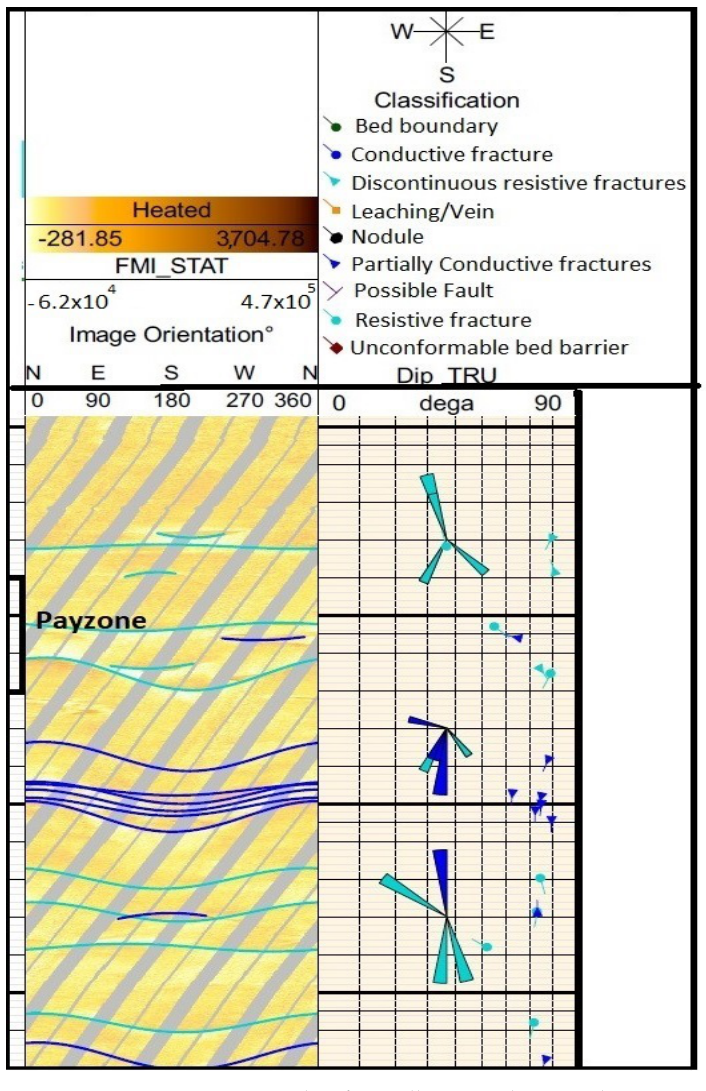
Figure 26. Formation image log for well X-02 indicating the presence of natural fractures in the granite